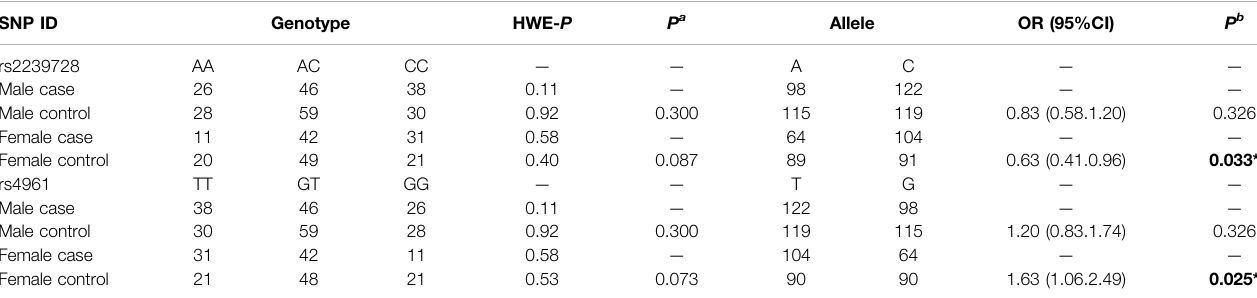
TABLE 9 | Association between ADD1 polymorphisms and the risk of EH among the Chinese Han population (adjusted by gender). SNP ID